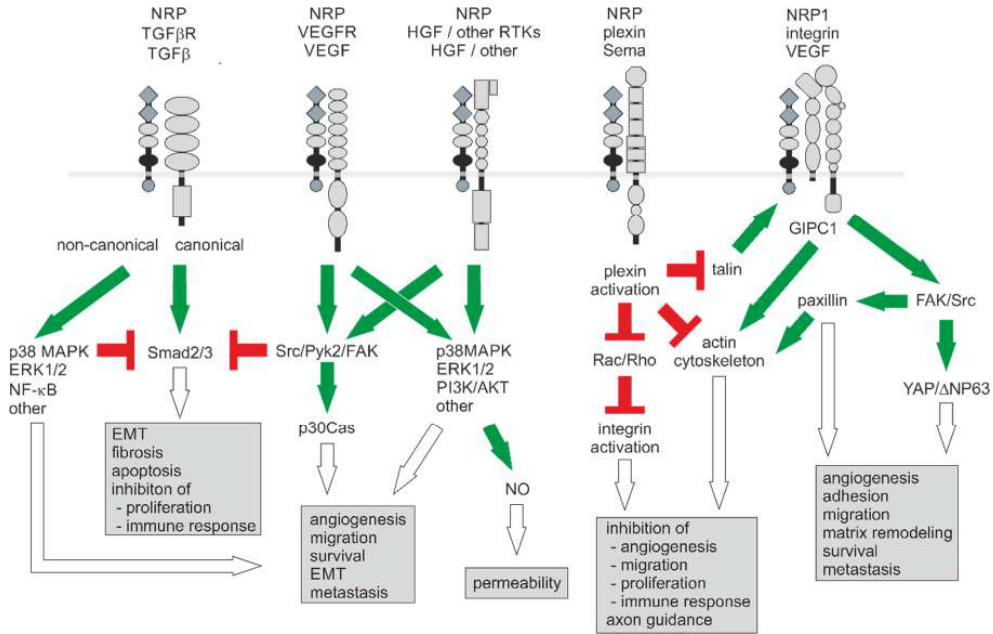
Figure 3. Neuropilin-1-triggered signaling pathways in the tumor vasculature and the tumor microenvironment. With two NRPs, numerous receptor/coreceptor combinations are possible, which can trigger a large number of cellular responses. For clarity, only monomers of receptors and coreceptors are shown. For signaling, dimerized ligands bind to a NRP dimer that interacts with a pair of receptor type kinases or plexin receptors. Activating and inhibitory signals are indicated in green and red, respectively. The resulting effects are indicated by open arrows. Modified from